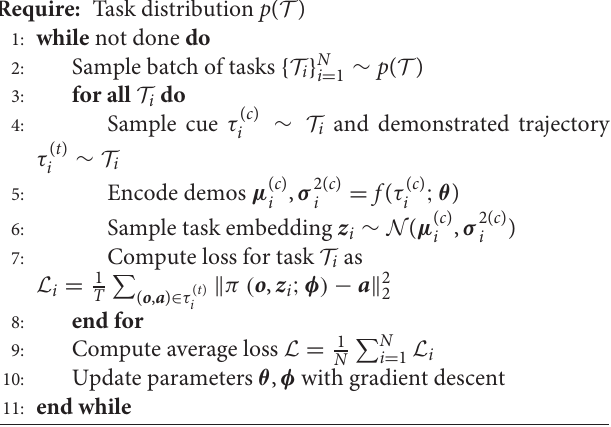
Algorithm 1 : Meta-training of PETNet.